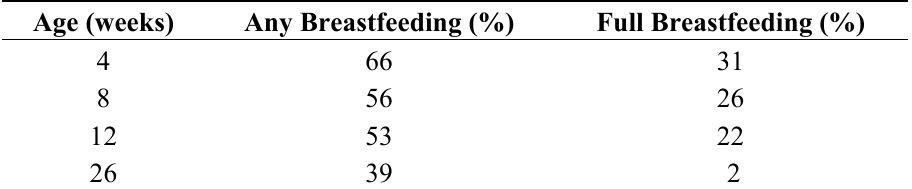
Table 1. Prevalence a of full and any breastfeeding at selected